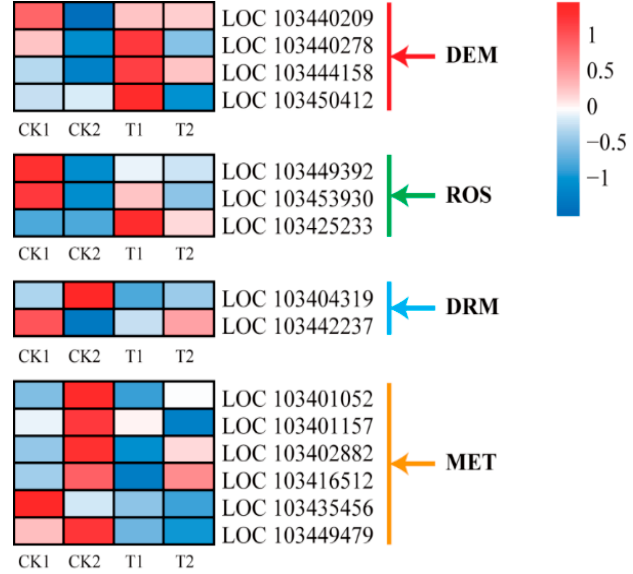
Figure 6. Heat map representation of expression patterns of methylase genes in “Granny Smith” apple skins. DME, demethylase; ROS, repressor of gene silencing; DRM, DNA (cytosine-5)-methyltransferase; MET, methyltransferase. Columns and rows in the heat map represent samples collected at different time points for which bags were removed. The color scale on the right represents the log-transformed FPKM value.